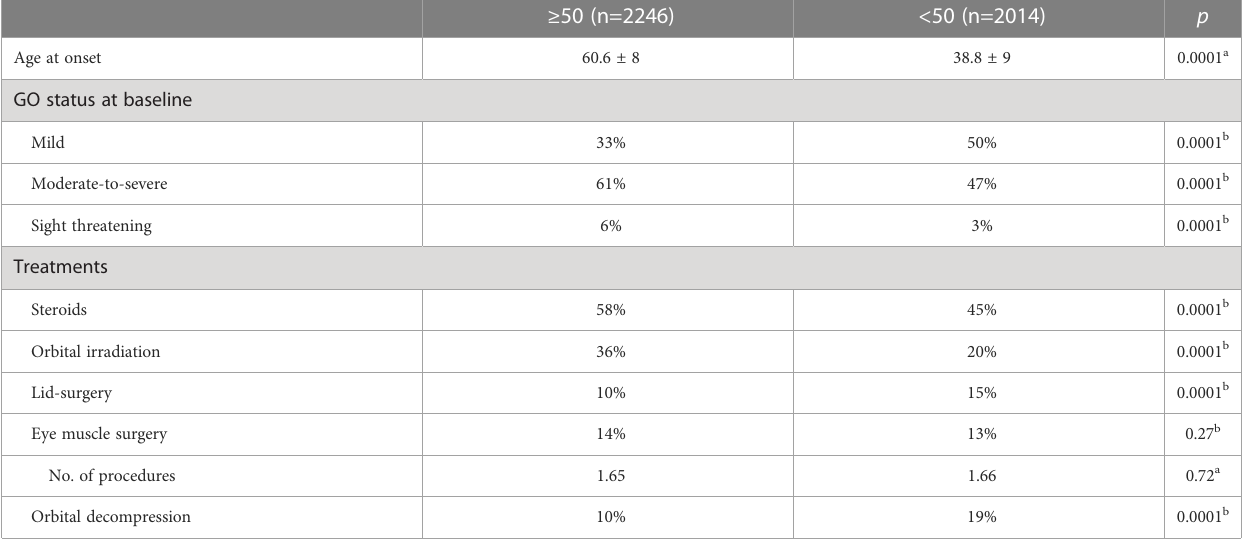
TABLE 4 Subgroup analysis strati fi ed by age ( ≥ 50 vs<50 years).